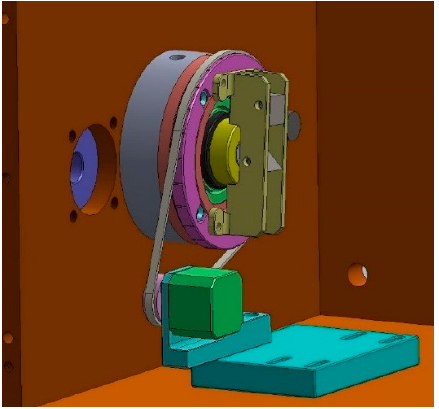
Figure 4. Top view of test rig designed displaying three sections from left to right: motor, trans- missions (gears), and seal test bench.